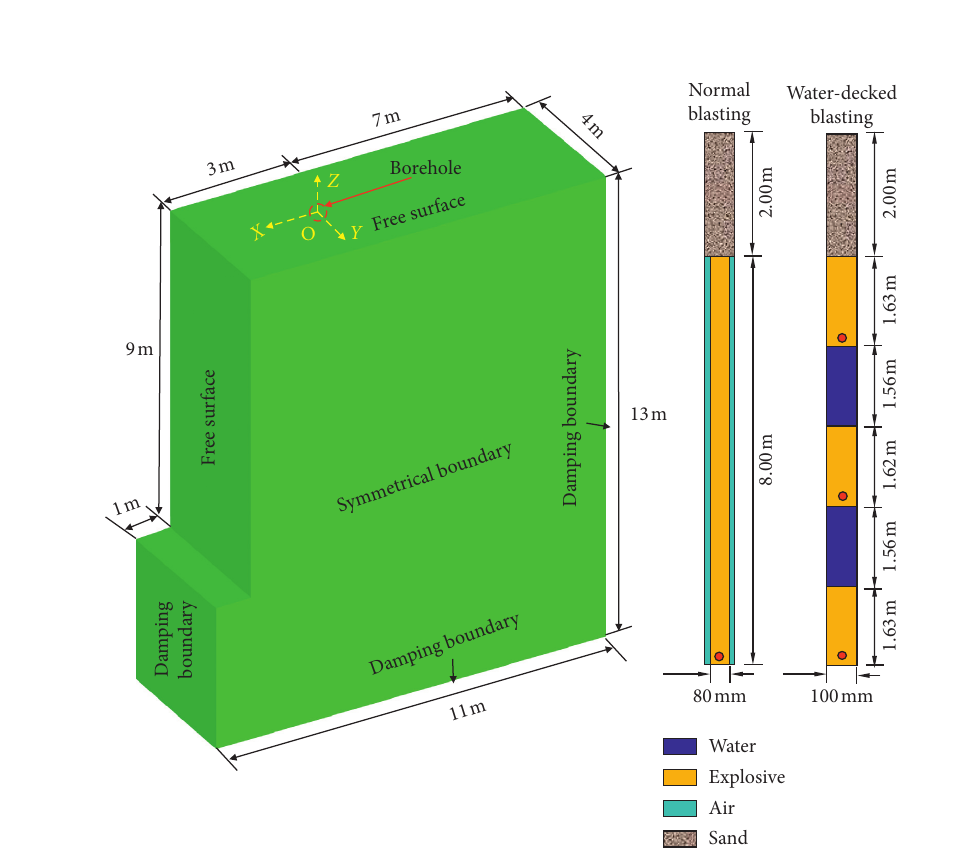
Table 1: Maximum borehole pressure of two types of charge patterns in theory. Type Normal blasting